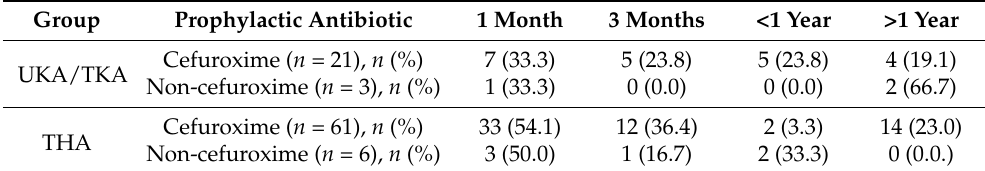
Table 4. Occurrence of PJI (%) over time in knee arthroplasty group and total hip arthroplasty group according to prophylactic